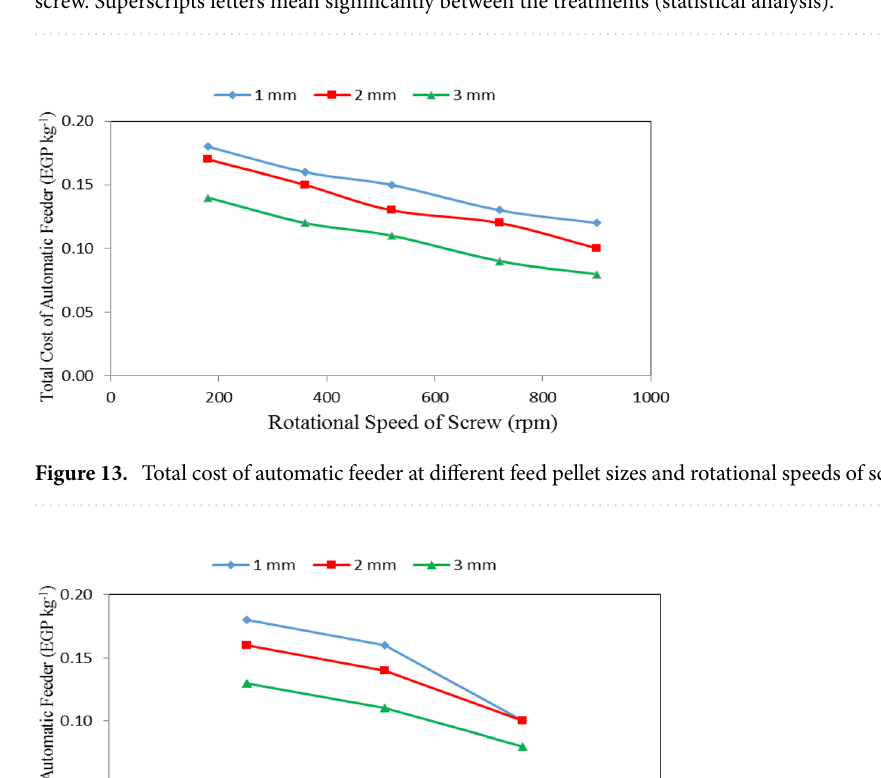
Table 4. Total cost of automatic feeder at different feed pellets sizes, air flow rate and rotational speeds of screw. Superscripts letters mean significantly between the treatments (statistical analysis).